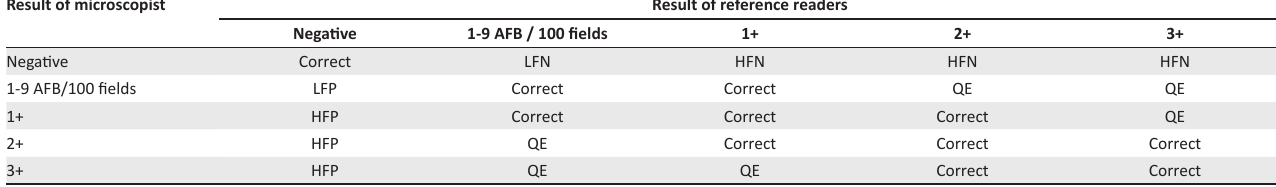
TABLE 1: Evaluation and interpretation of errors between rechecking laboratory microscopists and reference readers, Ethiopia, April–July 2015 †. Result of